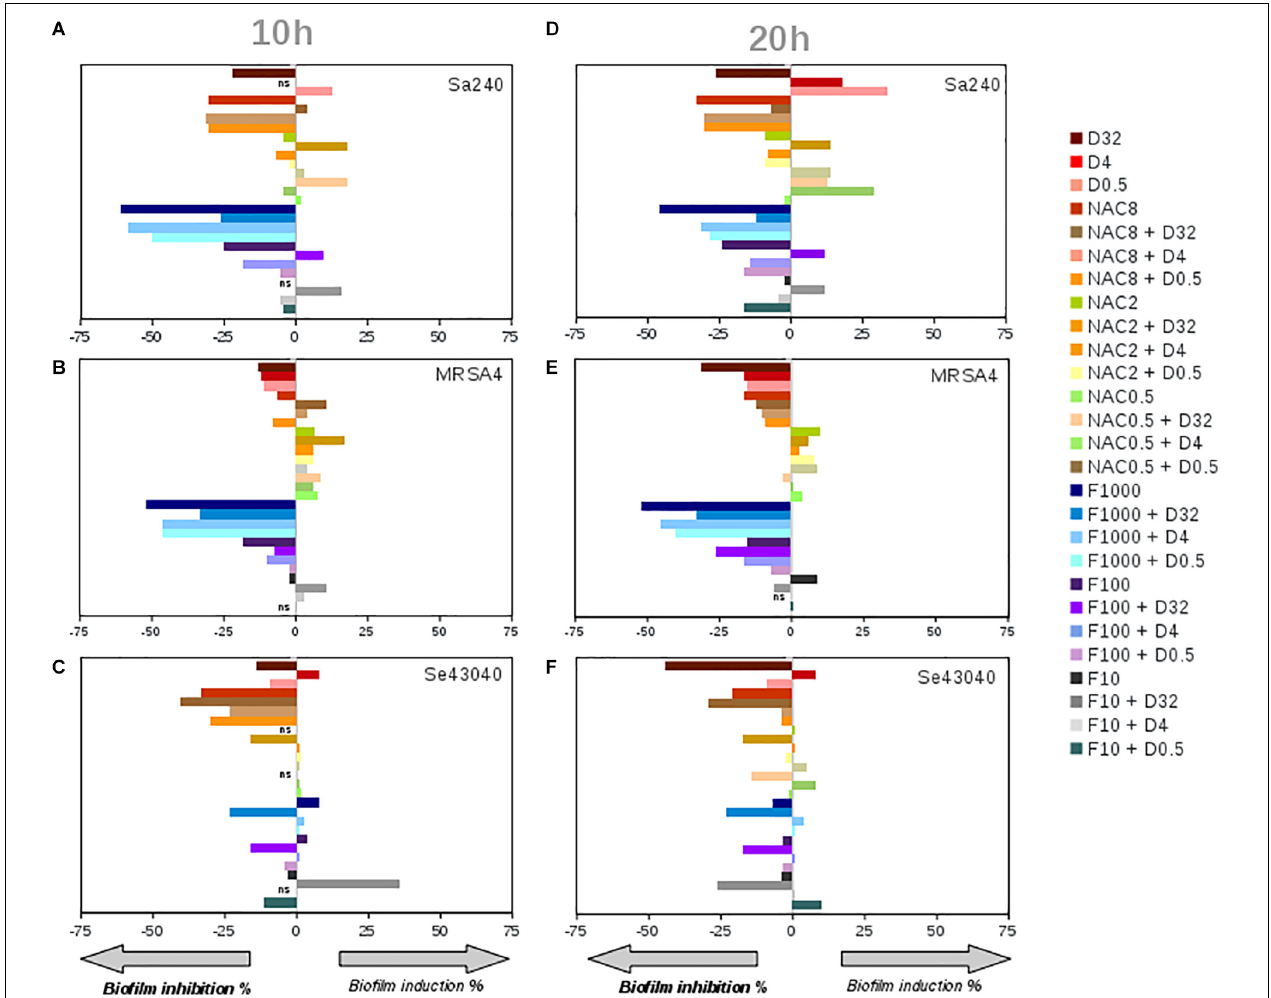
FIGURE 4 | Effect on the biofilm growth of Staphylococcus aureus 240 (A,D) , S. aureus MRSA4 (B,E) , and Staphylococcus epidermidis strains (C,F) , respectively, of the biofilm-detaching compounds ficin (F) (1,000, 100, 10 mg/L) and N -acetyl-L-cysteine (NAC) (8, 2, 0.5 g/L), and the antibiotic dalbavancin (D) (32, 4, 0.5 mg/L) alone or in combination. (A) , (B) and (C) graphs correspond to the induction or inhibition values observed at 10 h of biofilm formation shown as percentage relative to the control, while (D) , (E) and (F) to 20 h of biofilm growth, respectively. On the X axis, zero corresponds to biofilm mass of antimicrobial-free controls at 10 and 20 h of biofilm growth on an xCELLigence 96-well